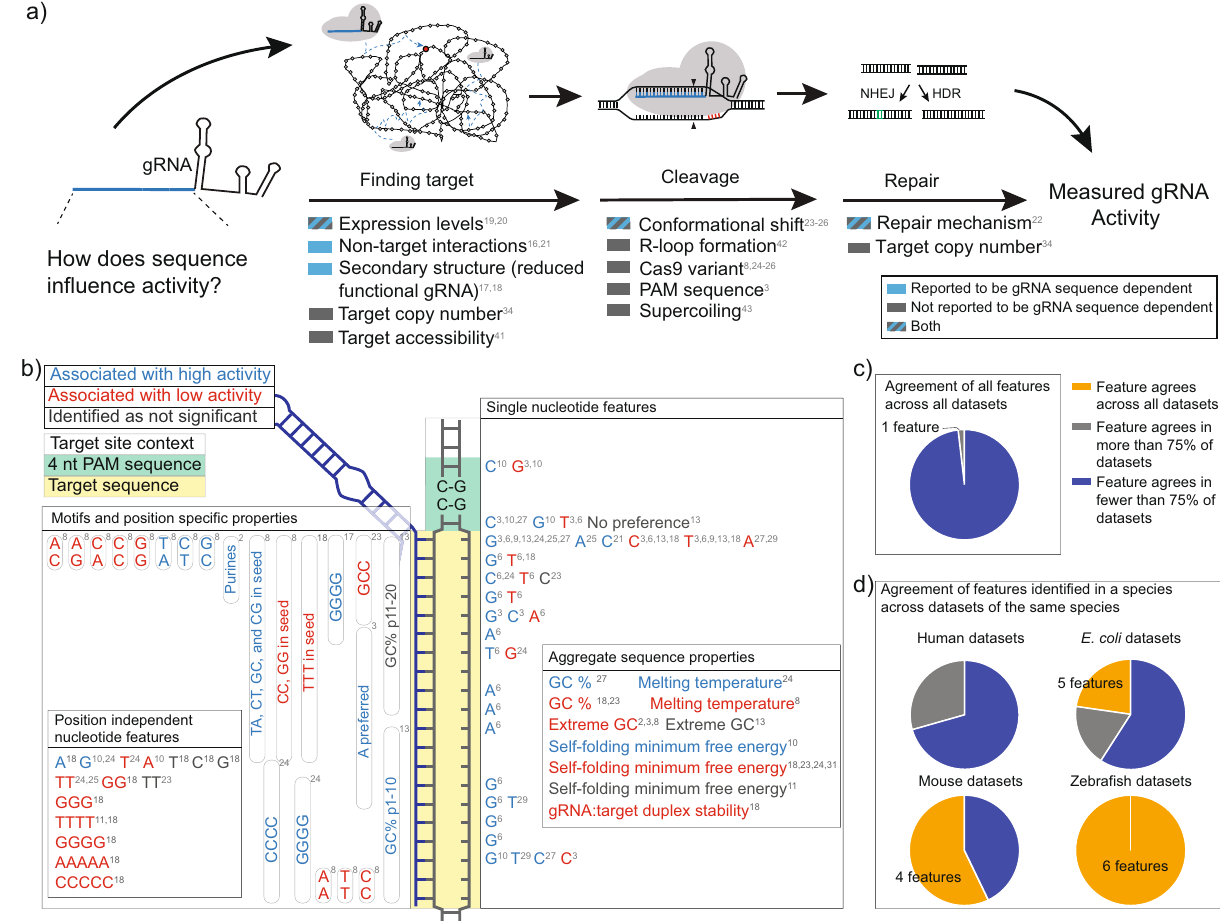
Fig. 1 Summary of known factors that in fl uence Cas9/gRNA complex activity and the reported gRNA sequence features identi fi ed as most important. a The gRNA sequence can at least partially predict on-target activity. Here, we provide a model of factors reported to in fl uence Cas9/gRNA complex activity and whether they impact fi nding the target site, cleaving the target, or repair of the target. b The gRNA:target duplex is highlighted in yellow and the PAM site is highlighted in green. Features that reportedly positively impact gRNA activity, have been identi fi ed as inhibitory to activity, or were speci fi cally identi fi ed as not signi fi cant are labeled in blue, red, and gray, respectively. Position dependent features are labeled in the relevant position while position independent features are shown in separately labeled boxes. c When comparing all datasets, there was no feature identi fi ed with a common impact on activity across all datasets and only one feature identi fi ed across 75% of the datasets. d The consistency of reported features across datasets of the same species. Of features identi fi ed as important in human datasets, no feature consistently had the same impact across human datasets. For other species, we identi fi ed fi ve, four, and 6 features that were consistent across datasets within the E. coli , mouse, and zebra fi sh datasets. Y. lipolytica was excluded from this analysis as there is only one